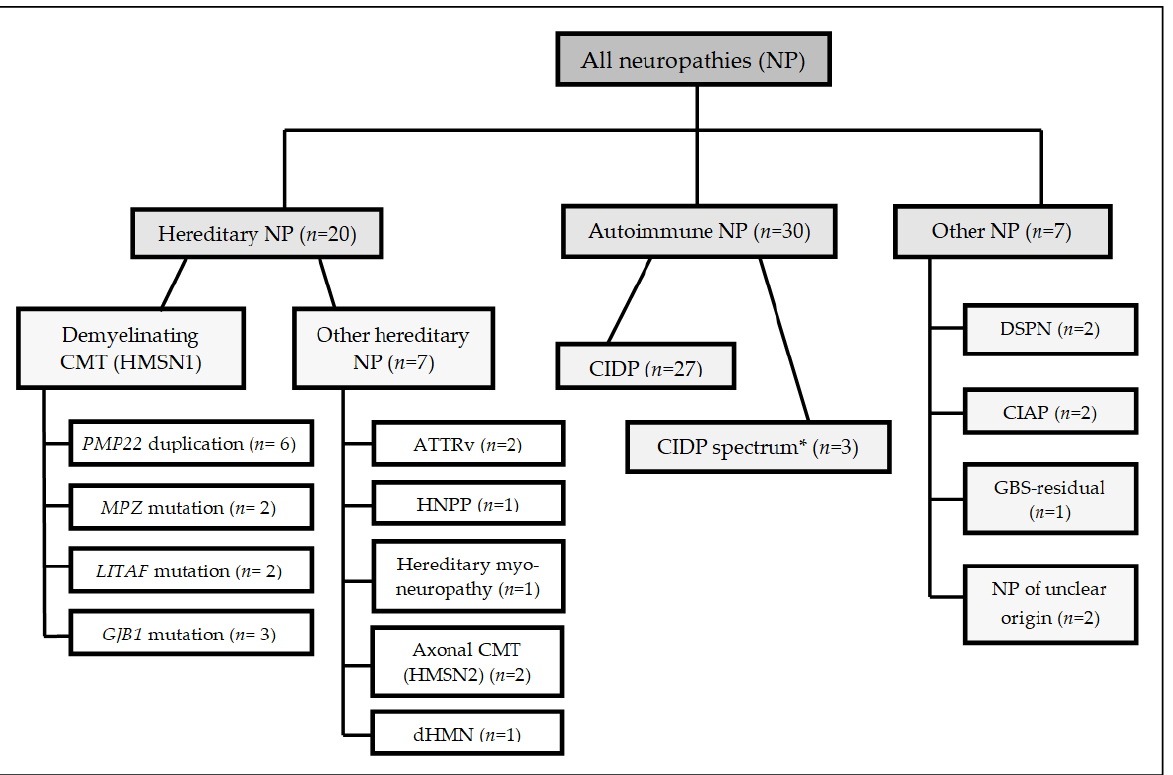
Figure 1. Organigram showing the etiologic classification of our study cohort and the particular numbers of each sub-collective. All mutations were heterozygous except for two male patients with hemizygous variants in GJB1 . * CIDP spectrum includes atypical CIDP and variants such as MMN or MADSAM. Abbreviations in Figure 1: ATTRv, hereditary transthyretin-related systemic amyloidosis; CIAP, chronic idiopathic axonal polyneuropathy; CIDP, chronic inflamma- tory demyelinating polyneuropathy; CMT, Charcot-Marie-Tooth disease; dHMN, distal hereditary motor neuropathy; DSPN, diabetic distal symmetric polyneuropathy; GBS, Guillain–Barrésyndrome; HMSN, hereditary motor and sensory neuropathy; HNPP, hereditary neuropathy with pressure palsies; MADSAM, multifocal acquired demyelinating sensory and motor neuropathy; MMN, multifocal motor neuropathy; NP, neuropathy. PMP22, MPZ, LITAF , and GJB1 : Genes that are associated with CMT. Table 1. Synopsis of the study population and means.